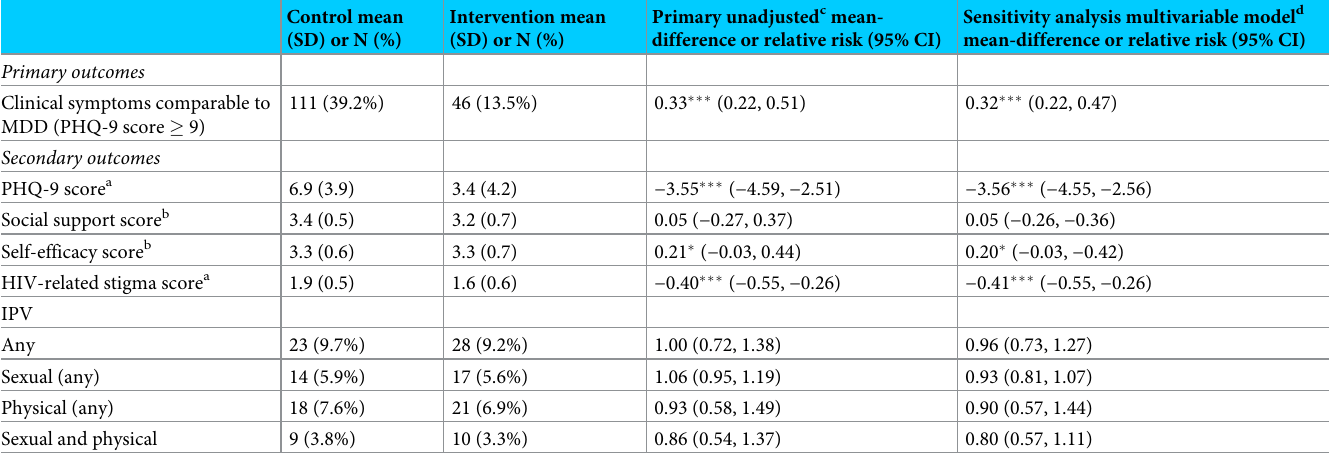
Table 3. Exploratory analysis of the effect of the intervention on primary and secondary outcomes at first follow-up, planned 6 weeks